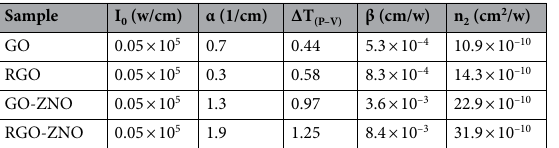
Table 1. The calculated nonlinear refractive index and nonlinear absorption coefficient using the Z-scan method.